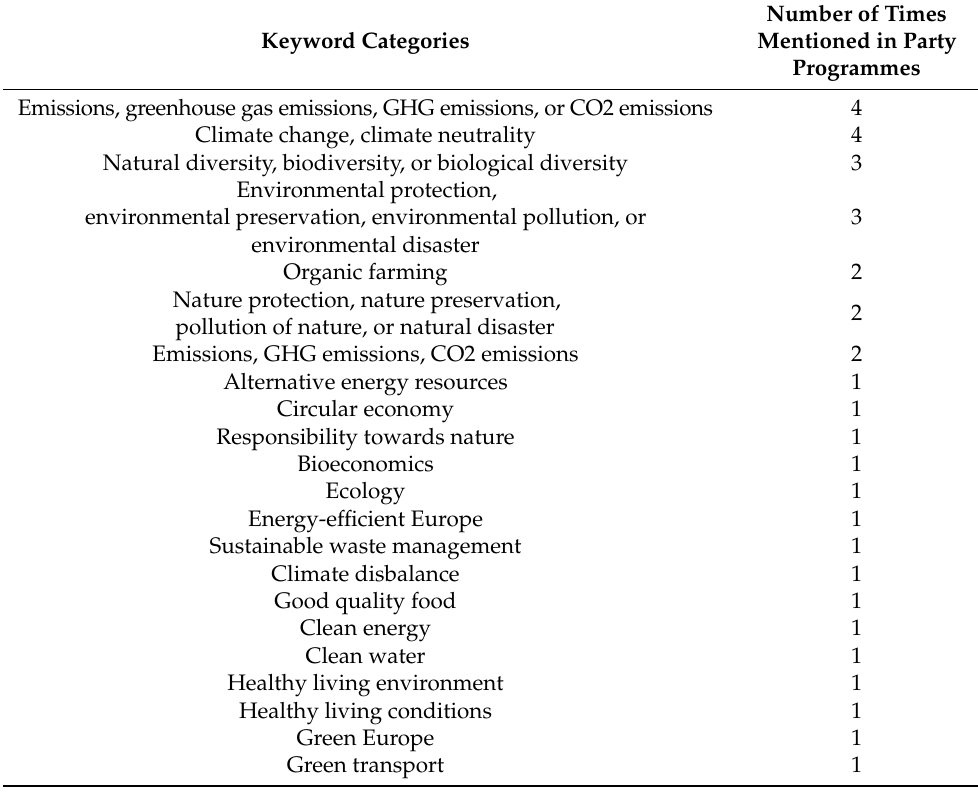
Table 2. Keywords most frequently mentioned in the context of climate change in party programmes.